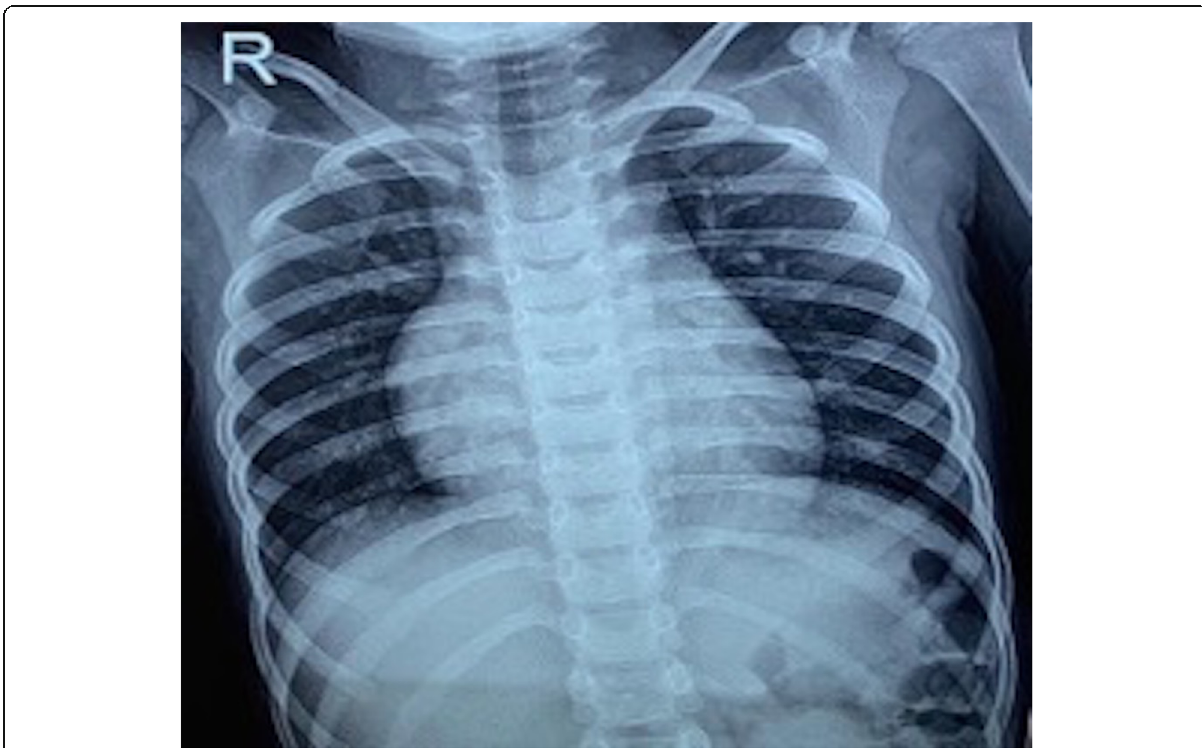
Fig. 2 Chest x-ray showing right atrial, pulmonary arterial enlargement with cardiomegaly and right ventricular apex. Numerous end-on vessels are seen over bilateral lung fields suggestive of increased pulmonary blood flow